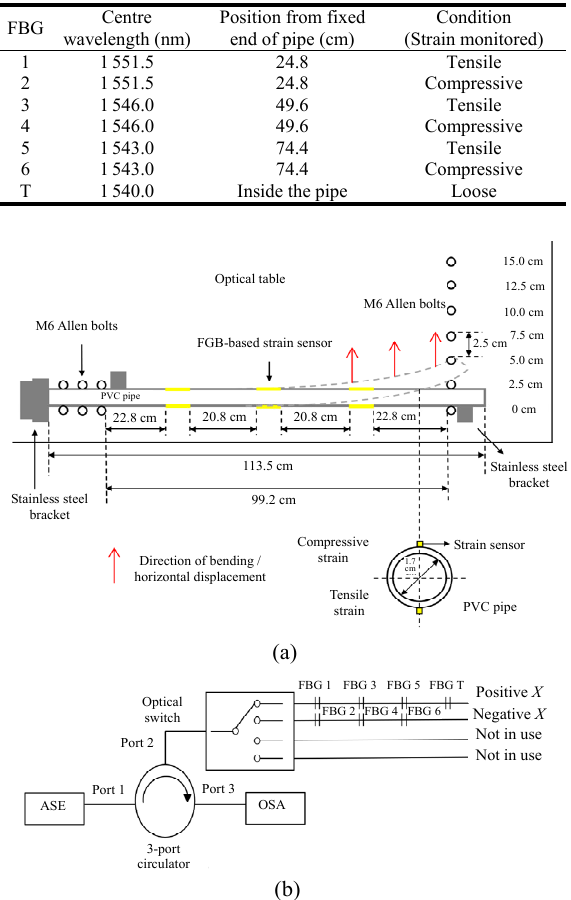
Table 1 FBGs and their respective central wavelengths.